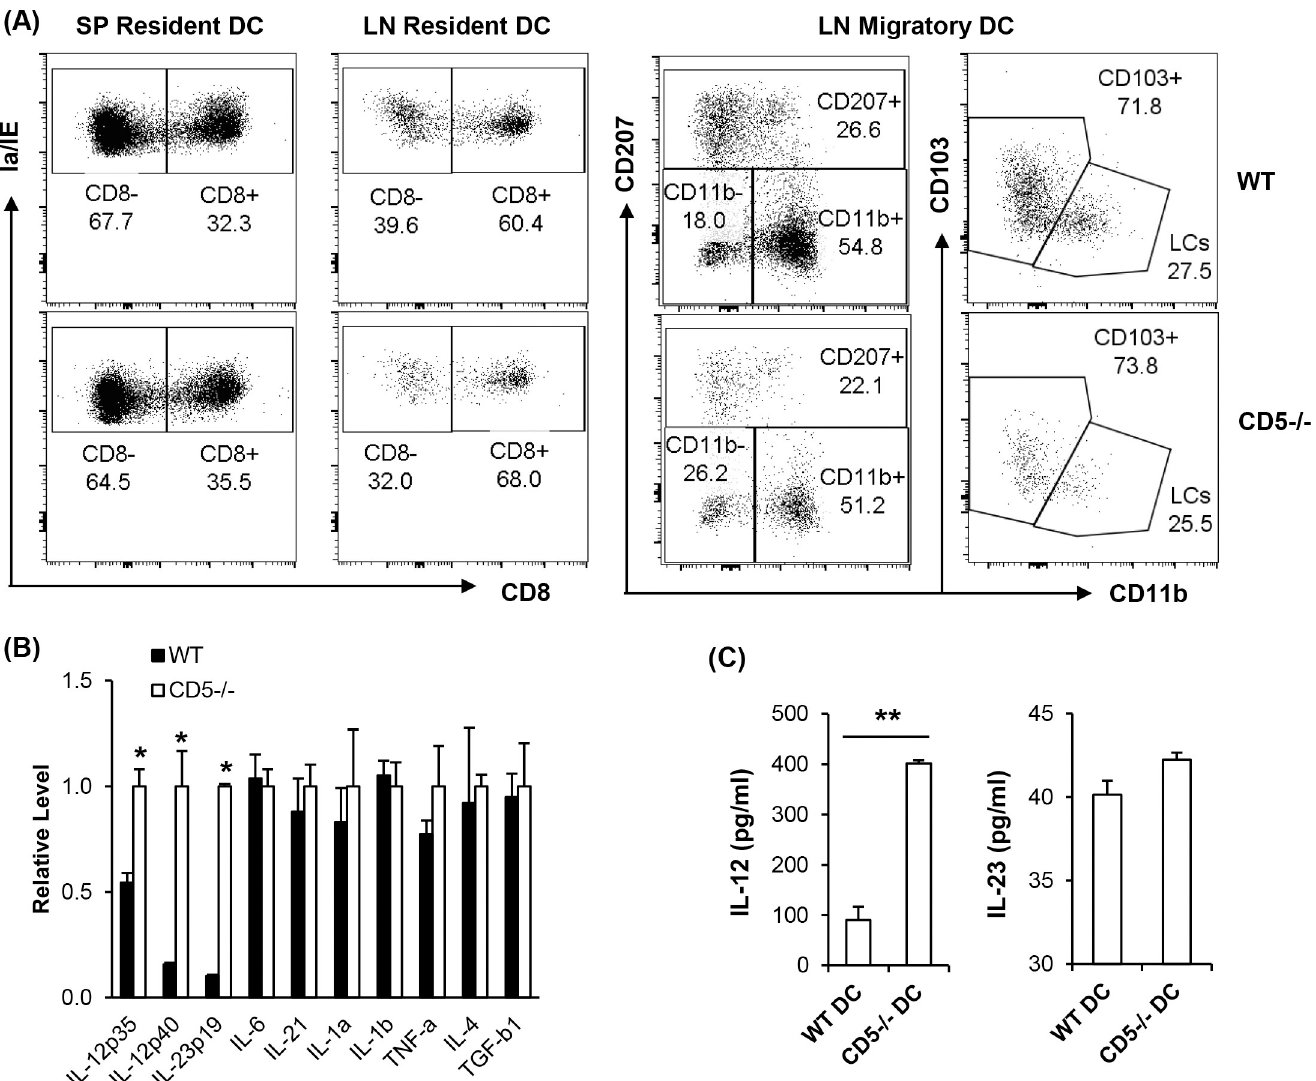
Fig 2. Effects of CD5 deficiency on DC. (A) DC from wild-type (WT) (upper panels) and CD5 -/- (bottom panels) mice are gated as described in the Fig 1 and resident and migratory DC populations are analyzed. The numbers in the graphs show the percentage of the indicated DC subsets. (B) CD5 deficiency alters cytokine production by BMDC. Levels of cytokine mRNA from WT and CD5 -/- BMDC are quantified by real time RT-PCR (n = 4, � P < 0.05). (C) CD5 deficiency increases IL- 12 production by DC. SP DC from WT and CD5 -/- were purified by CD11c coupled MACS beads and stimulated with LPS for 24 hours. Cytokine concentrations in culture supernatants were measured by ELISA (n = 3, �� P < 0.01). The data are representative of 2–3 independent experiments (two-tailed Student’s t -test).